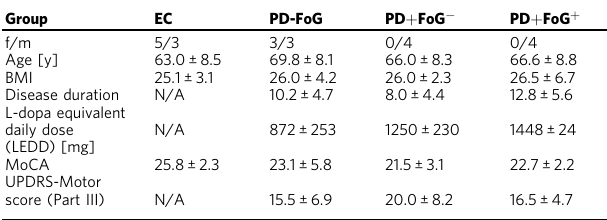
Fig. 5 Intra-lobe brain interactions in the frontal motor lobe for the individual subjects performing different motor tasks. a Symbols represent the average values of FMR − FMR and FML − FML α - band interactions as derived from the R × χ matrix during normal walking (blue squares), standing still (green diamonds), and hand tapping (red circles). Values for each task are arranged in columns and each symbol represents an individual subject. The different groups are marked by different background shadings. Fitting lines highlight the trend towards higher brain lobe interactions for subjects with PD and FoG, which is seen across all three motor tasks. b Scatter plots show strong cross-correlations between the different motor tasks and con fi rm the observation of an increase of brain interactions with PD severity. The colors of the symbols correspond to the background shadings in ( a ) for patients belonging to different groups. Pearson ’ s correlation coef fi cients ρ are highly signi fi cant ( p < 10 − 3 ) and are shown in the upper left corner of each subplot. The insets con fi rm the signi fi cance of the results by surrogate analysis (i.e., shuf fl ing the number tuples of the subjects by n iterations, with n = 0 being the original un-shuf fl ed tuple series). Table 2 Demographic and clinical data of the study groups.